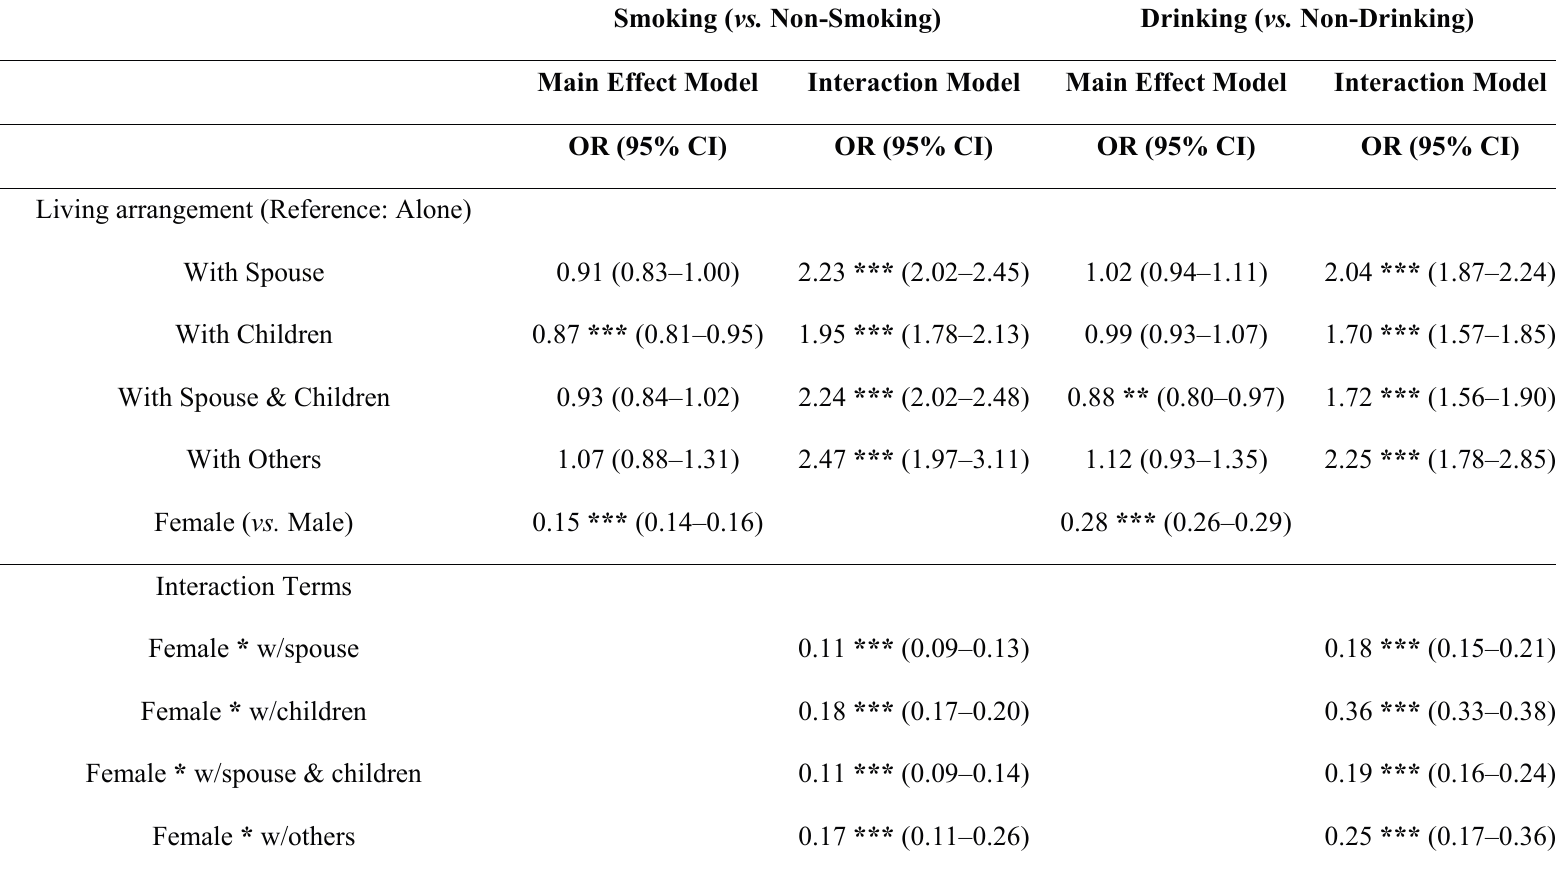
Table A5. Multivariate logistic regression predicting smoking and drinking among Chinese older adults: CLHLS, 1998–2008 pooled sample with and without interaction